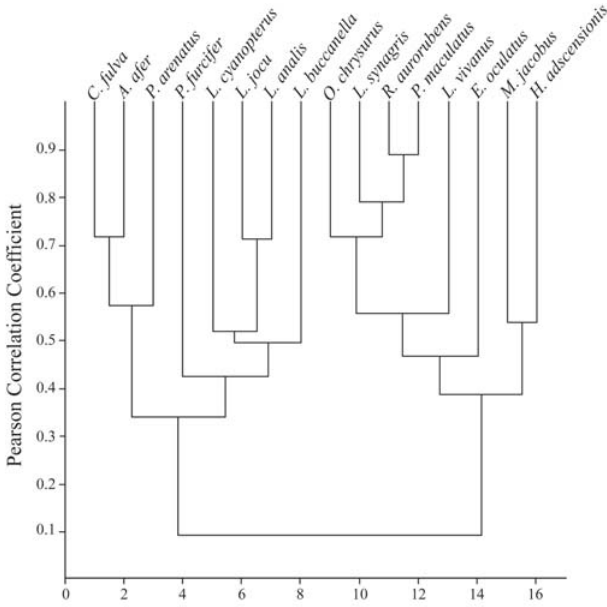
Fig. 2. Similarity dendogram for the morphologic and color criteria used by the interviewed fishermen from Ilhéus, Bahia State, Brazil, to classify the species of the snapper group (number of interviews = 15; for the E . oculatus and P . furcifer n =